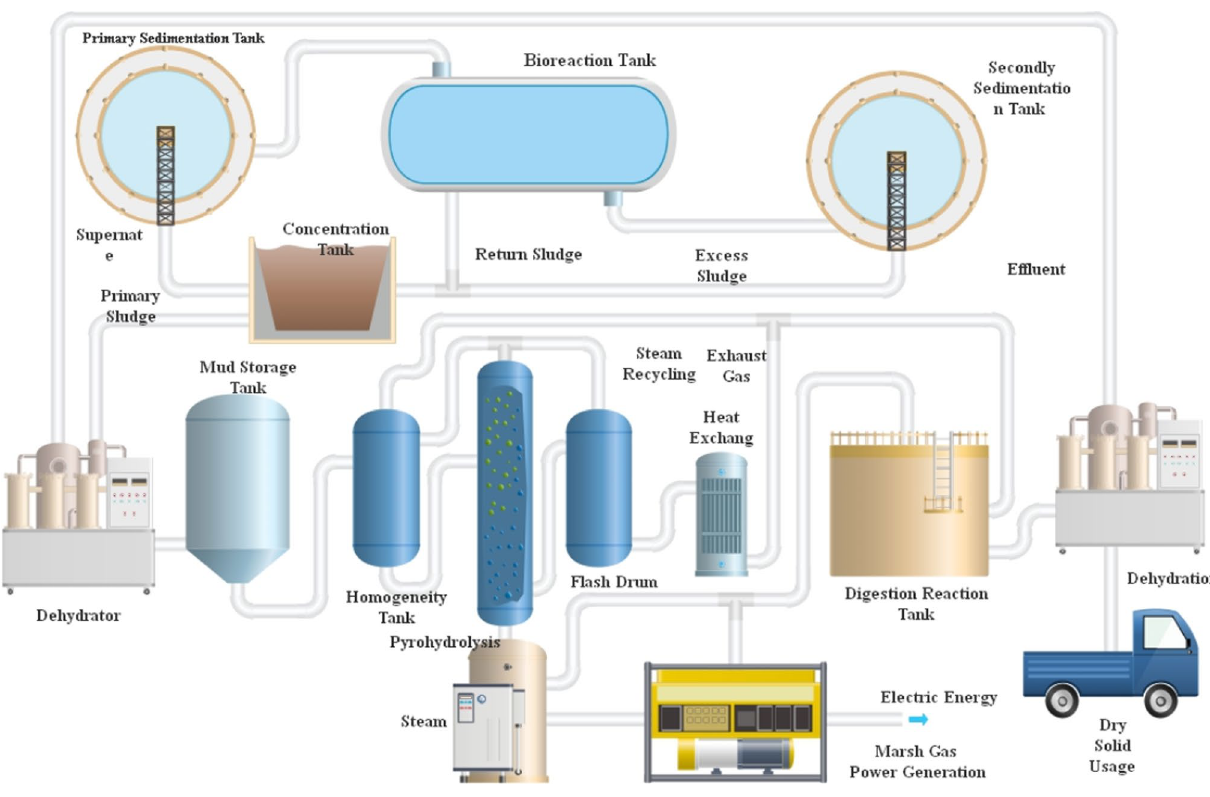
Fig. 1 Sewage sludge reuse system craft